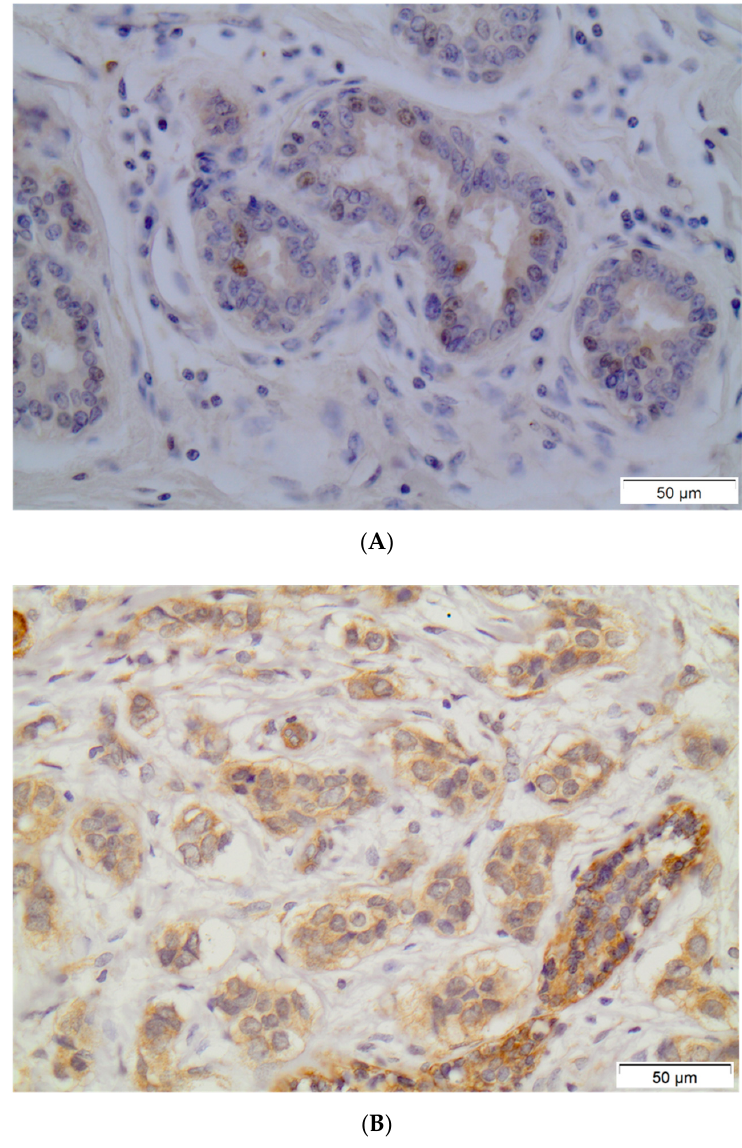
Figure 1. Representative PXR immunostainings in normal breast ductules ( A ) and in breast invasive carcinoma ( B ). Streptavidin-biotin-peroxidase, DAB chromogen, Harris hematoxylin counterstain (original magnification ×200, scale bars are present on figures). Out of 148 breast carcinoma cases, 65 (43.9%) were ER positive. PR positivity was noted in 60 (40.5%) out of 148 breast carcinoma cases, while 15 (10.1%) cases were HER2 positive. Out of 148 breast carcinoma cases, 59 (39.4%) were classified as luminal-A, 18